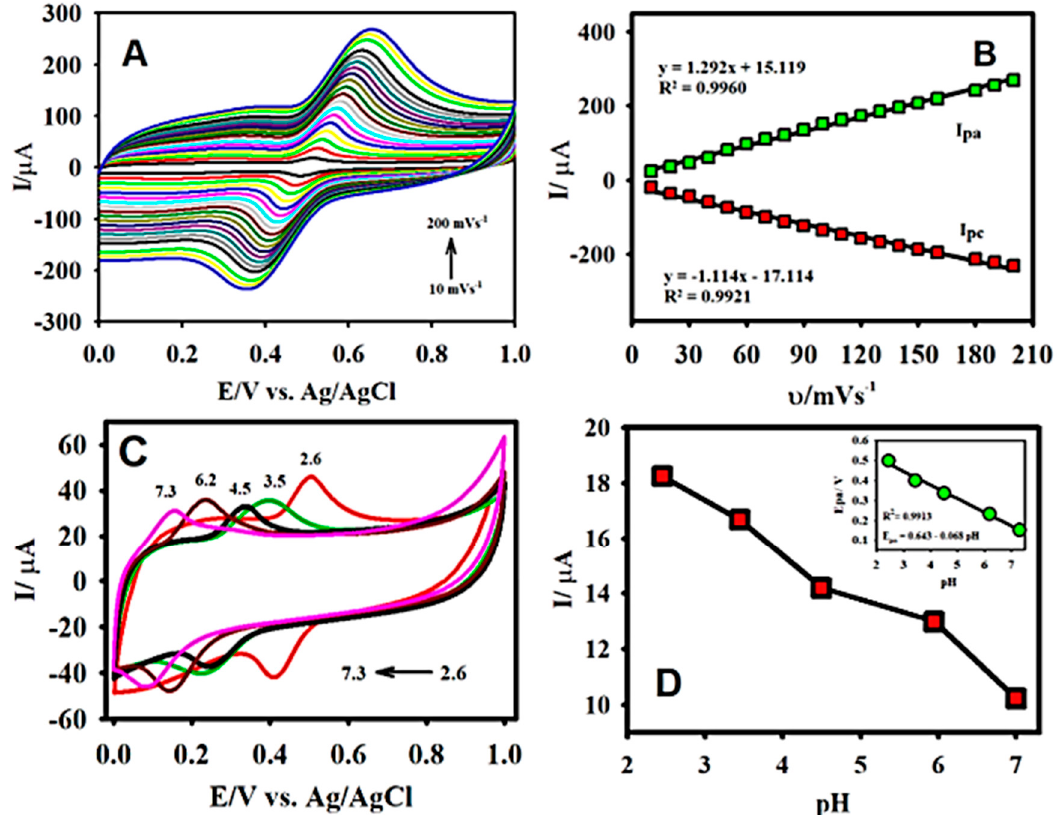
Figure 5. The CV response of F-GO/GCE recorded in the presence of 50 µ M CA at different scan rates varying between 10 to 200 mV s − 1 ( A ) and the subsequent plot of anodic/cathodic peak current vs. the scan rate (mV s − 1 ) ( B ); the CV curves for the oxidation of 30.0 µ M CA at different pHs (2.6–7.3) ( C ); and the resulting plot of anodic peak current vs pH ( D ) and the corresponding plot of the anodic peak potential vs. pH (insert of D). Electrolyte: 0.1 M B-R buffer solution pH 2.65; scan rate: 50 mV s − 1 .